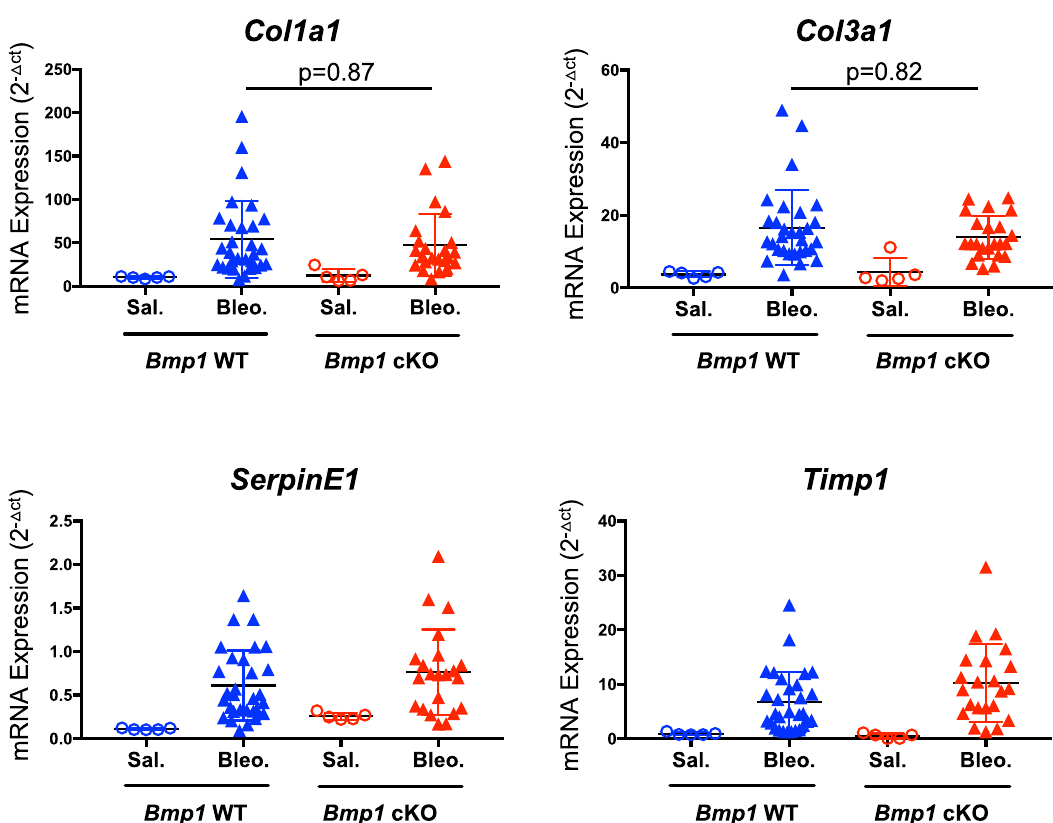
Figure 5. Bmp1 deletion has no effects on pro-fibrotic gene expression. mRNA expression of selective pro- fibrotic genes from lung tissue. Bmp1 WT: Saline n = 5, bleomycin n = 30; Bmp1 cKO: saline n = 5, bleomycin n = 21. Data represents mean ± SD. p-value is calculated using one-way